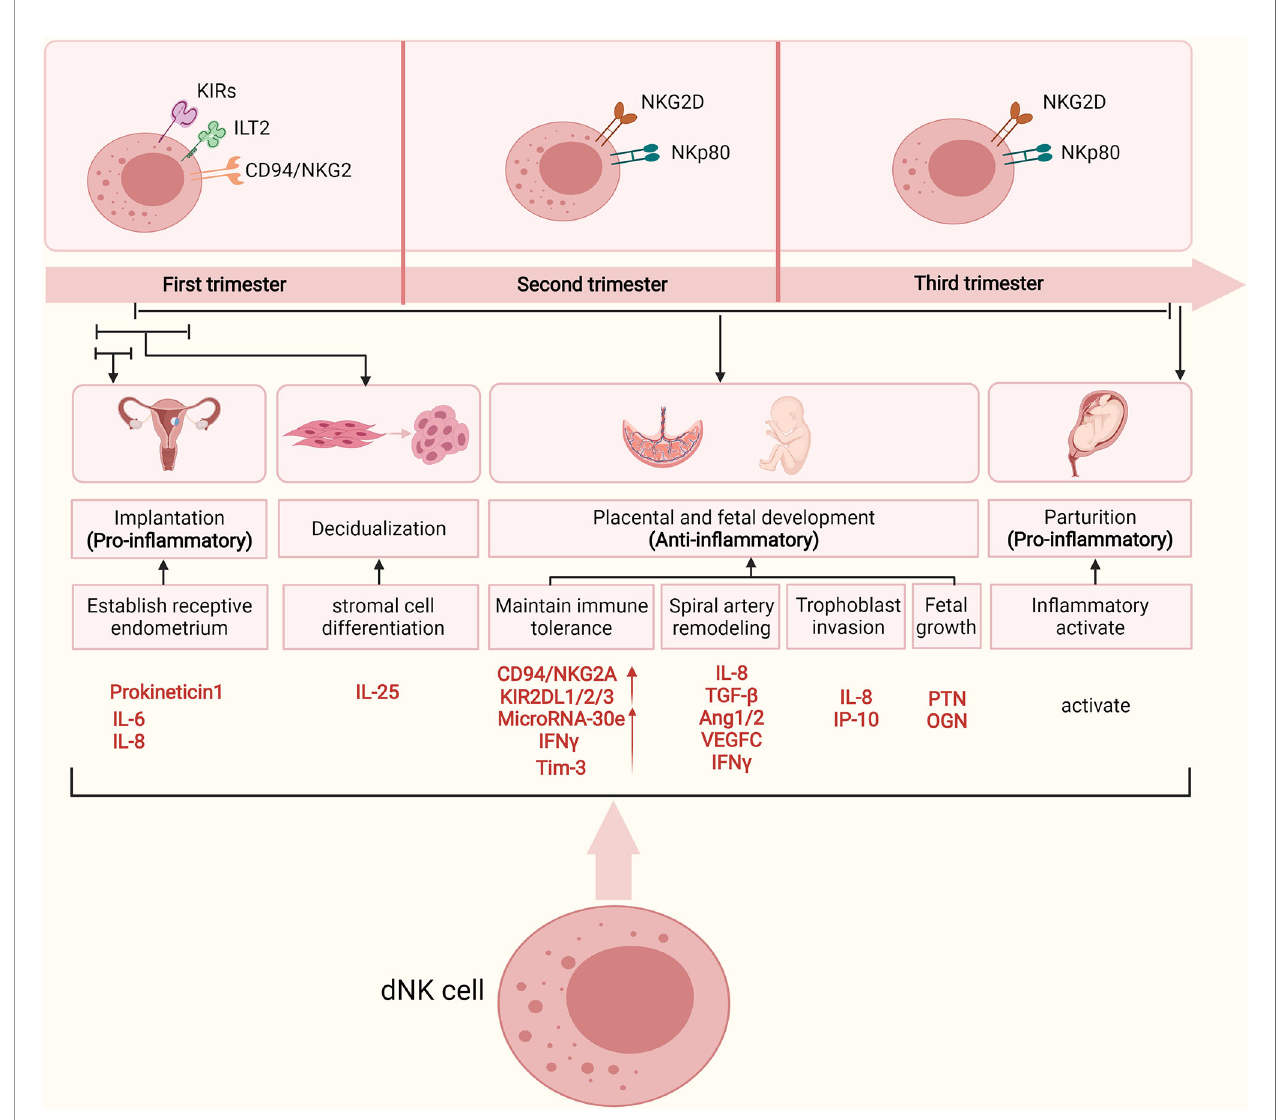
FIGURE 1 | The primary roles dNK cells during key stages of human pregnancy and major subtypes of dNK cells in different trimesters. During early pregnancy, uNK cells highly express prokinetincin1, a marker of receptive endometrium, and proin fl ammatory factors (IL-6, IL-8) facilitating the embryo to implant into endometrium. dNK cells facilitate ESC decidualization by secreting IL-25. During human placental and fetal development, inhibitor receptors expressed on dNK cells (such as KIRs, CD94/NKG2) interact with HLA ligands expressed on EVTs to depress the cytotoxic capability of dNK cells, thus maintaining immune tolerance in maternal-fetal interface. Up-regulation of microRNA-30e, Tim-3 and IFN- g in dNK cells also contributes to the immune tolerance in maternal-fetal interface. dNK cells participate in the remodeling of spiral arteries by secreting chemokines, cytokines and vasoactive factors, such as IL-8, TGF- b , IFN- g , Ang-1/2, VEGF-C. dNK cells can also promote fetal development through secreting PTN and OGN. At late gestation, the activation of NK cells leaded to labor by inducing a maternal systemic pro-in fl ammatory response. In addition, the major dNK cell subtype classi fi ed by receptor expression are shown for the different trimesters. The fi gure was created with